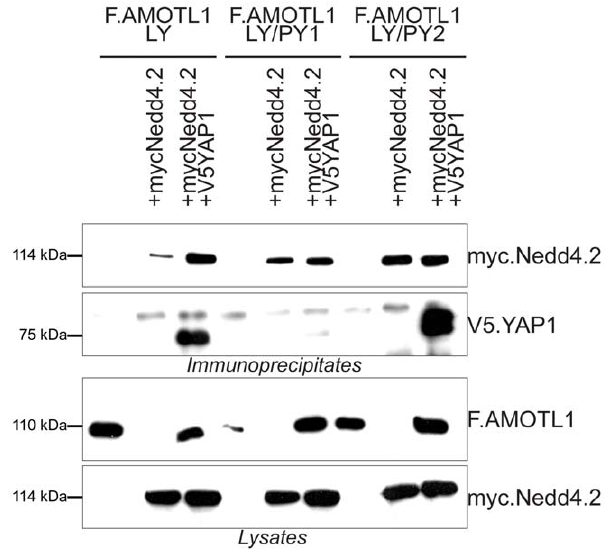
Figure 6. YAP1-AMOTL1 binding requires the AMOTL1 motifs LPTY and the PPEY. Either of Flag-tagged AMOTL1 188–191A (LY: LPTY, amino acids 188–191), AMOTL1 188–191A/310–313A (LY/PY1:LPTY, amino acids 188–191 and PPEY, amino acids 310–313) or AMOTL1 188–191A/367–370A (LY/PY2: LPTY, amino acids 188–191 and PPEY, amino acids 367–370) mutants were used to precipitate YAP1. Immunoblotting was carried out using the indicated antibodies.